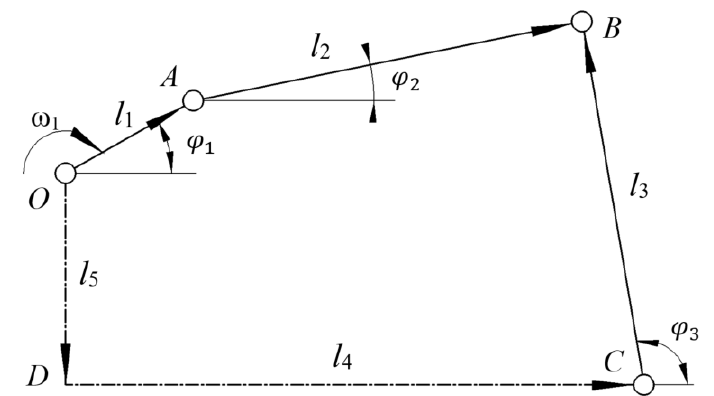
Figure 2. Vector relationship of the drive rod.